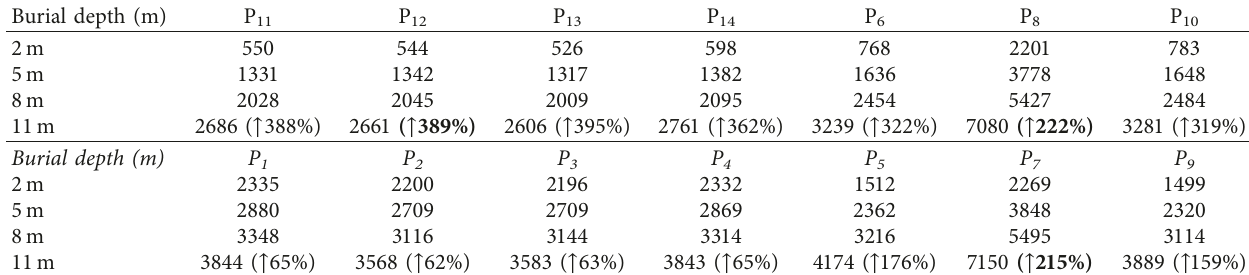
Table 2: The maximum axial forces at typical sections of the structure with different burial depths (unit: kN). Burial depth (m)